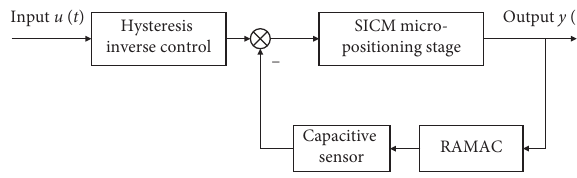
Figure 4: Control system of FRAMAC.